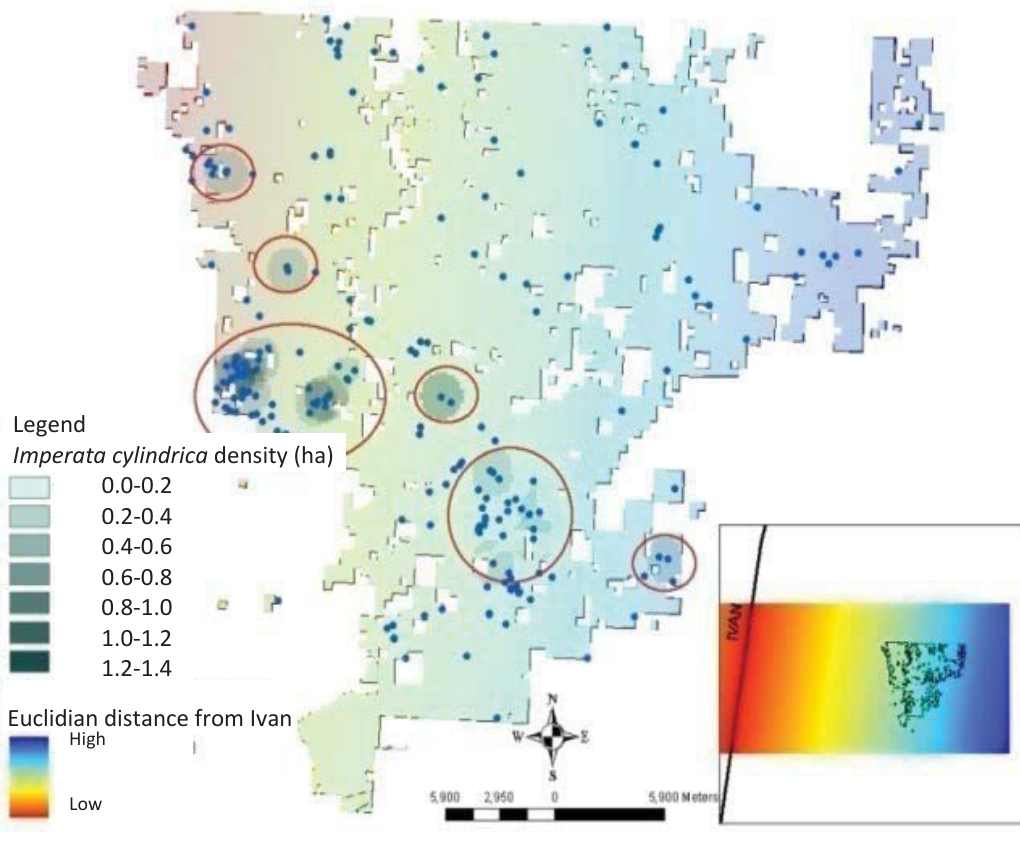
Figure 6. Overlay map of Imperata cylindrica density and Euclidian distance from hurricane Ivan in Blackwater River State